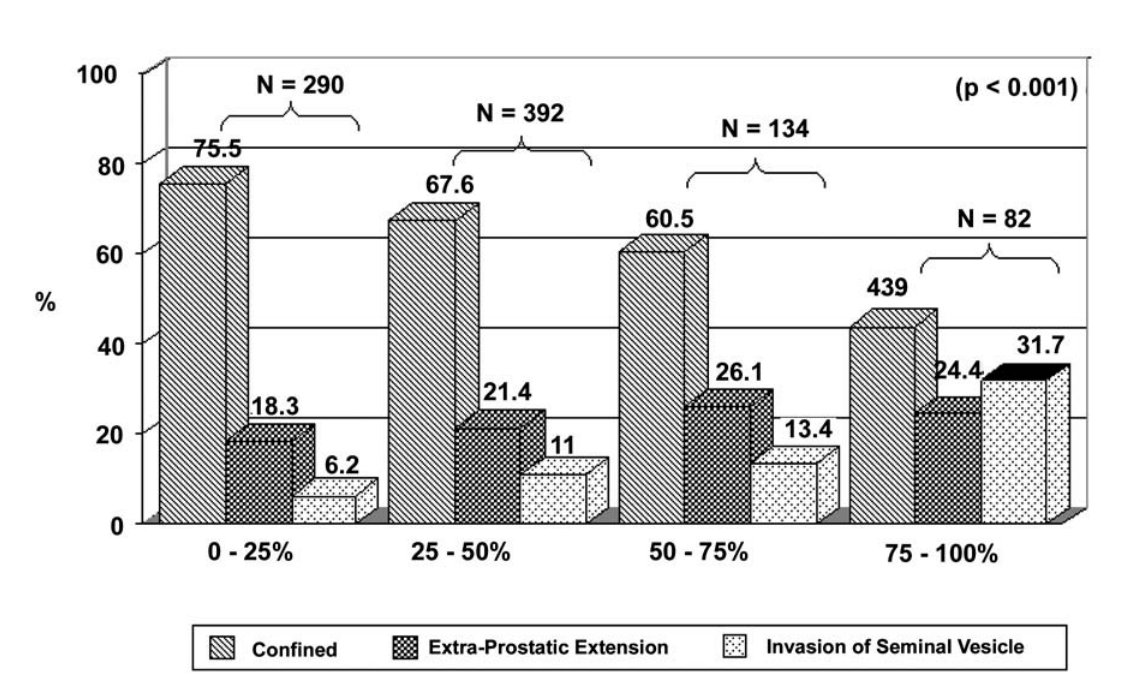
Figure 2 – Distribution of percentage of positive fragments according to the extension of prostate